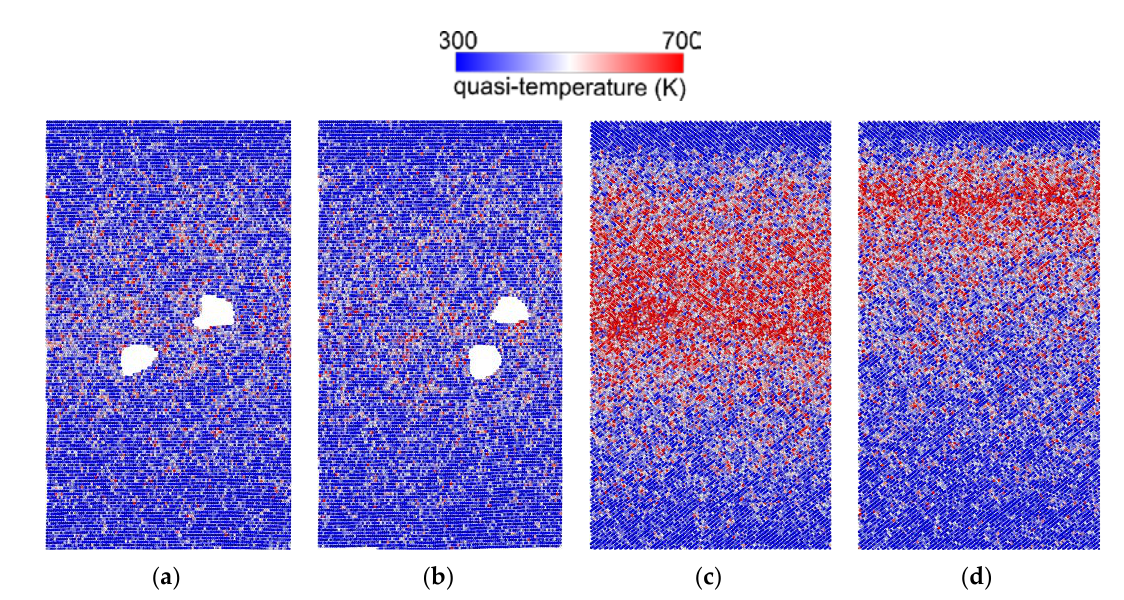
Figure 7. The quasi-temperature evolution in Model I after the first ( a ) and the fifth ( b ) cycle, and in Model II after the first ( c ) and fifth ( d ) cycle of sinusoidal sliding under the applied clamping pressure of 135 MPa.